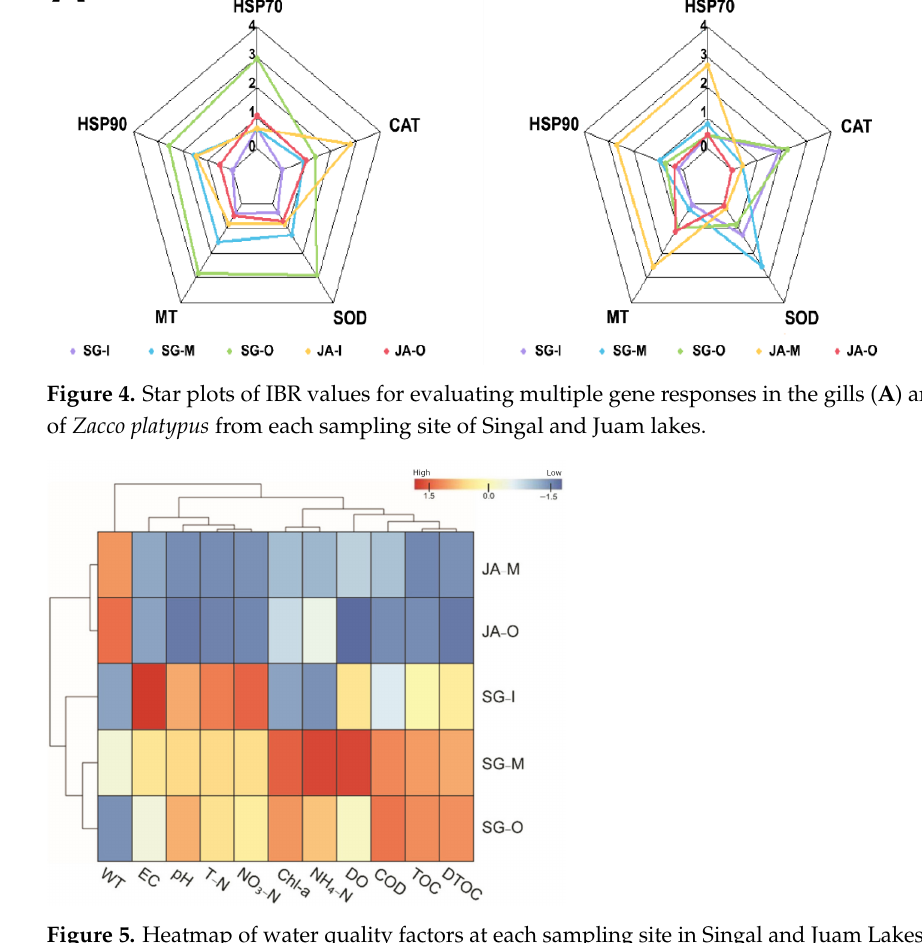
Figure 5. Heatmap of water quality factors at each sampling site in Singal and Juam Lakes. Cell color represents high or low levels of water quality factors. Each group underwent Z-score nor- malization.